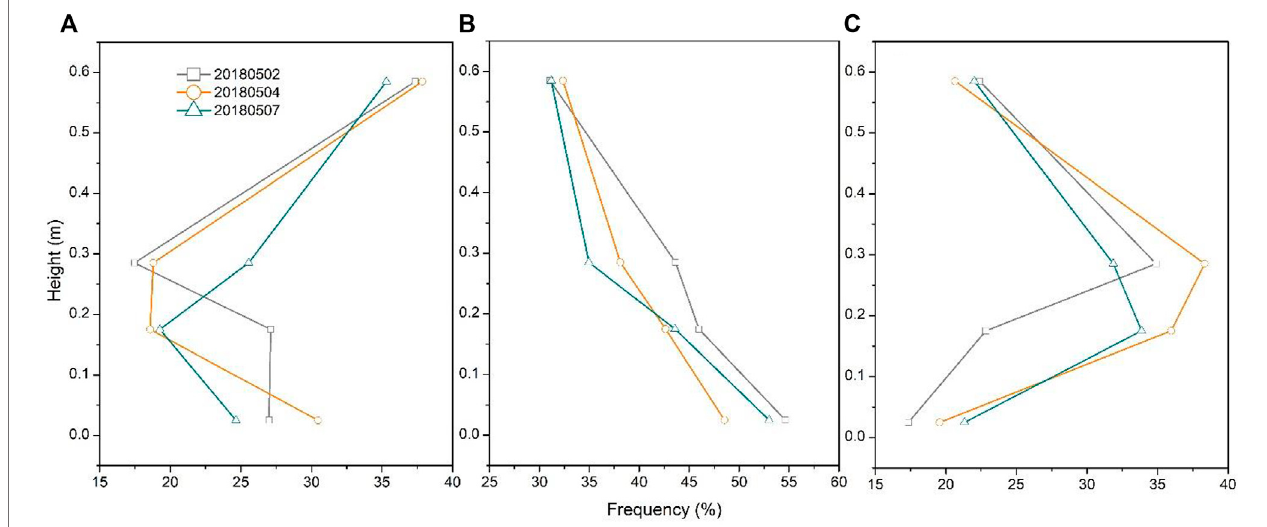
FIGURE 7 | Variation of frequencies for three grain-size groups with height in the three transport events. (A) very fi ne sands (63 – 125 μ m), (B) fi ne sands (125 – 250 μ m), and (C) medium sands (250 – 500 μ m).